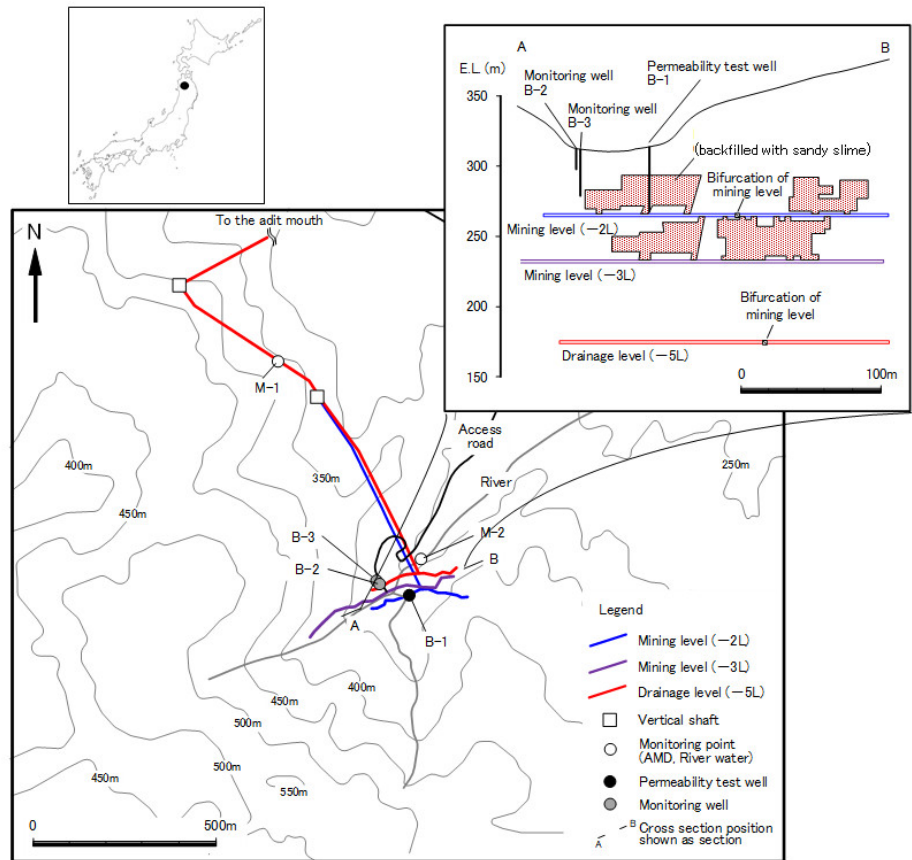
Figure 1. Distribution of old mining levels and excavated underground space of the study area.